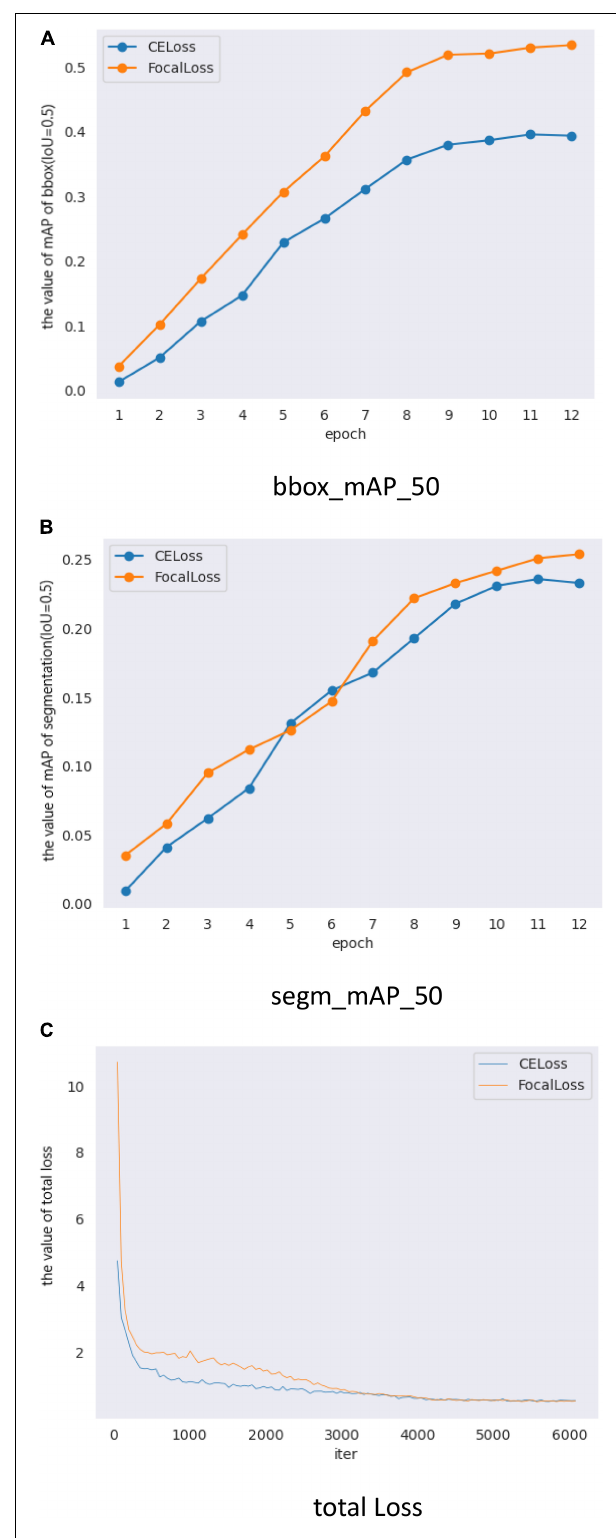
FIGURE 5 | Mask R-CNN with different loss validation parameters and loss functions. (A) Comparison of mAP_50 of bbox (IoU = 0.5) on different loss, (B) Comparison of mAP_50 of segmentation (IoU = 0.5) on different loss, and (C) Comparison of total loss.